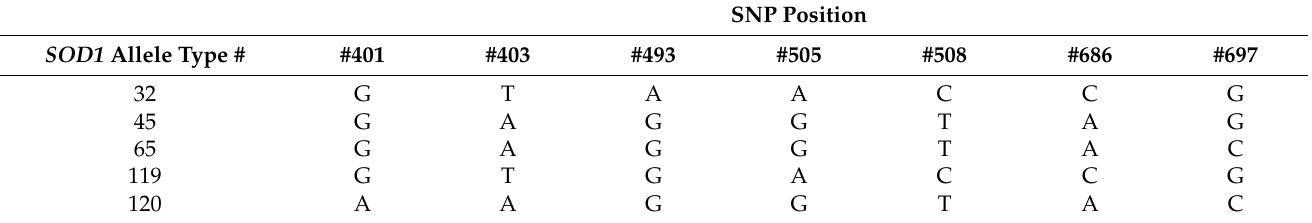
alleles in the most variable locus, SOD1 (Table 3). Table 3. Nucleotides for each of the five SOD1 allele types (AT) at the SNP positions in the aligned se- quences. SNP